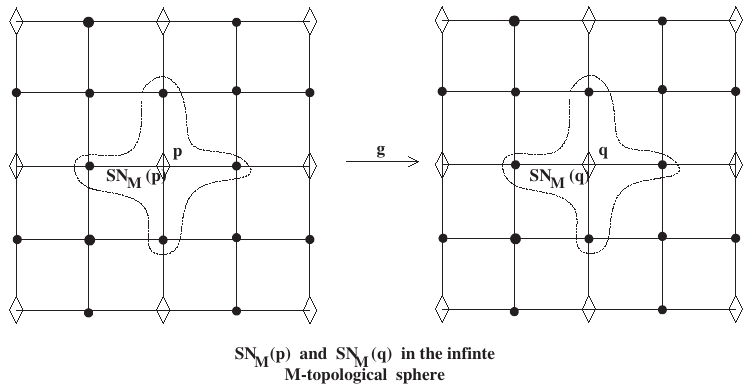
Figure 1. Configuration of a continuous self-map g of (( Z 2 ) ∗ , γ ∗ ) such that g (( Z 2 ) ∗ ) = SN M ( q ) with the property (9), q ∈ ( Z 2 ) E